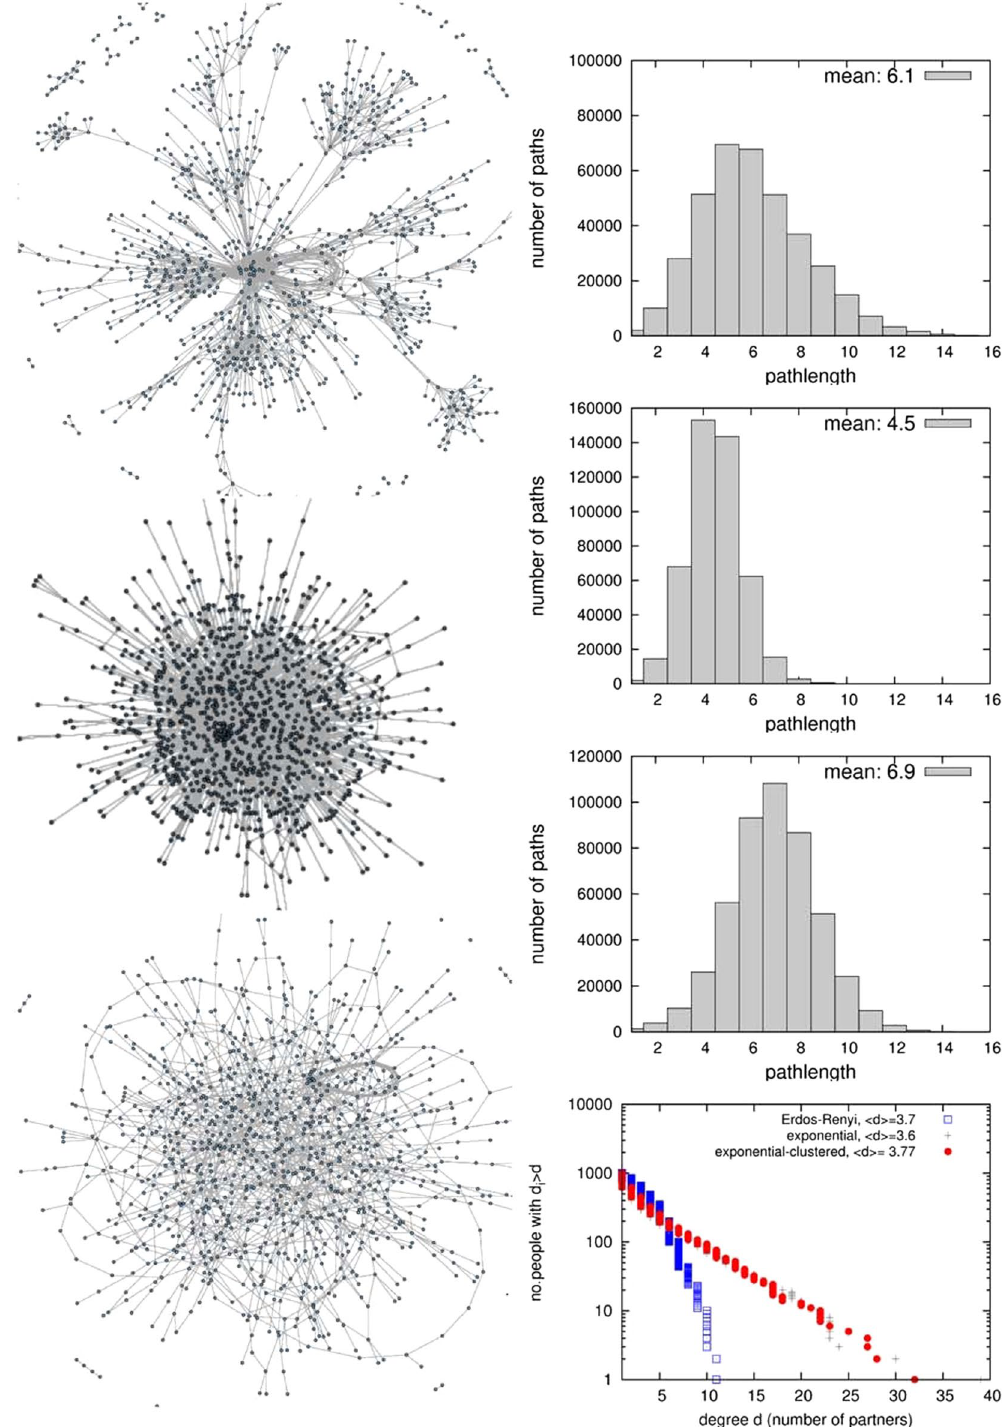
Figure 1. The three networks compared in this analysis. Right column: distribution of path-lengths in the network, and average path-length Inlay: Counter-cumulative representation of the degree distributions of the three networks in log-linear scale, where a straight line corresponds to an exponential distribution (both for the counter-cumulative distribution and for the probability density, which is its